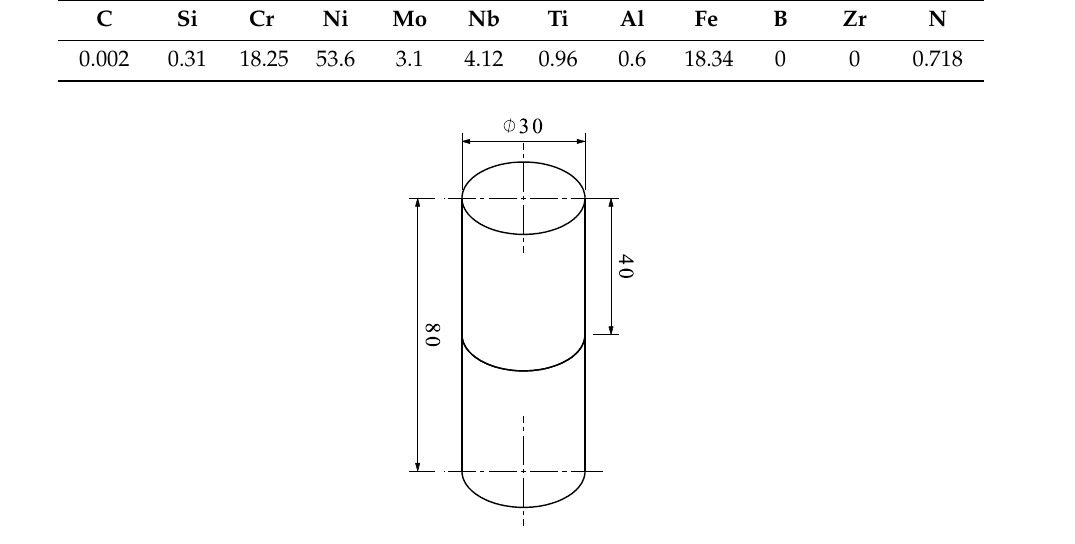
Table 1. Chemical composition (wt %) of Inconel 718.